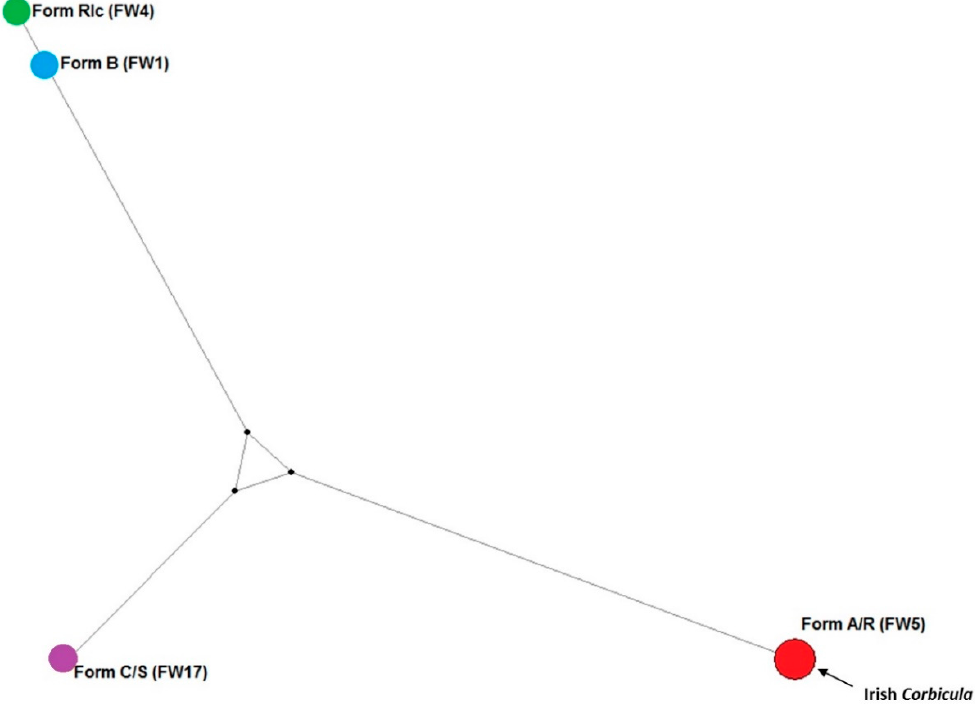
Figure 4. Haplotypic diversity and relationships in Invasive Corbicula clams inferred through median-joining Network. The European invasive haplotypes FW1 (Form B), FW4 (Form Rlc), FW17 (Form C / S), FW5 (Form A / R; Irish individuals) are plotted. Branch length was proportional to the number of mutations between the haplotypes and nodes proportional to the haplotype frequency.